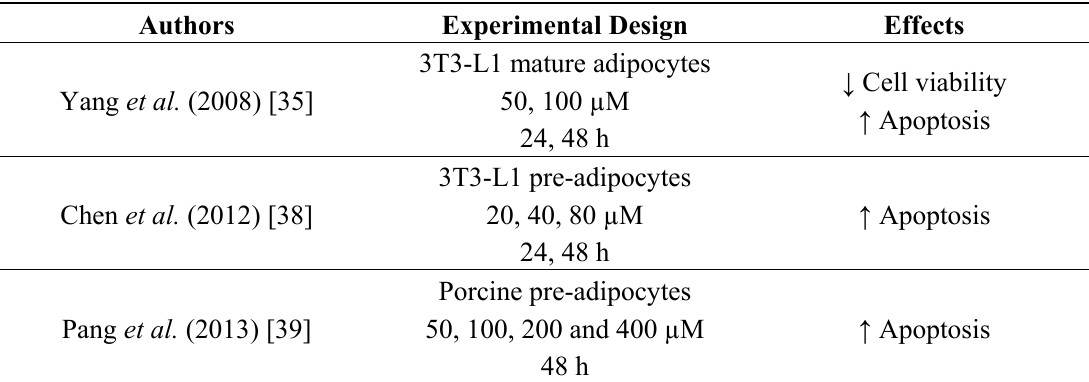
Table 2. Effects of resveratrol on